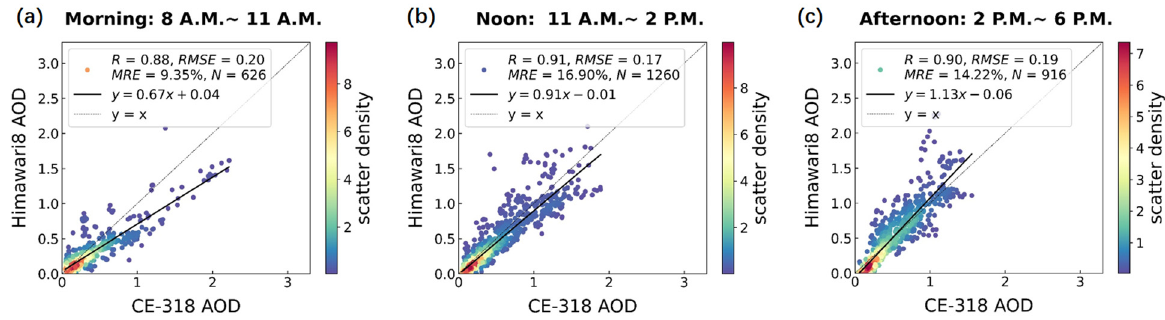
Figure 3. Box plot of the error between AHI and sun photometer AOD with respect to the size of AOD from August 2017 to March 2019 ( a ); the error between MODIS and sun photometer AOD with respect to the size of AOD ( b ); the error between AHI and sun photometer AOD with respect to the Ångström index Alpha ( c ); the error between MODIS and sun photometer AOD with respect to the Ångström index Alpha ( d ). The dark blue boxes represent the upper and lower quartiles, the black line represents the upper and lower edges of the data, and the red horizontal line inside the box represents the data mean. The red dashed line represents the envelope EE of the expected error.